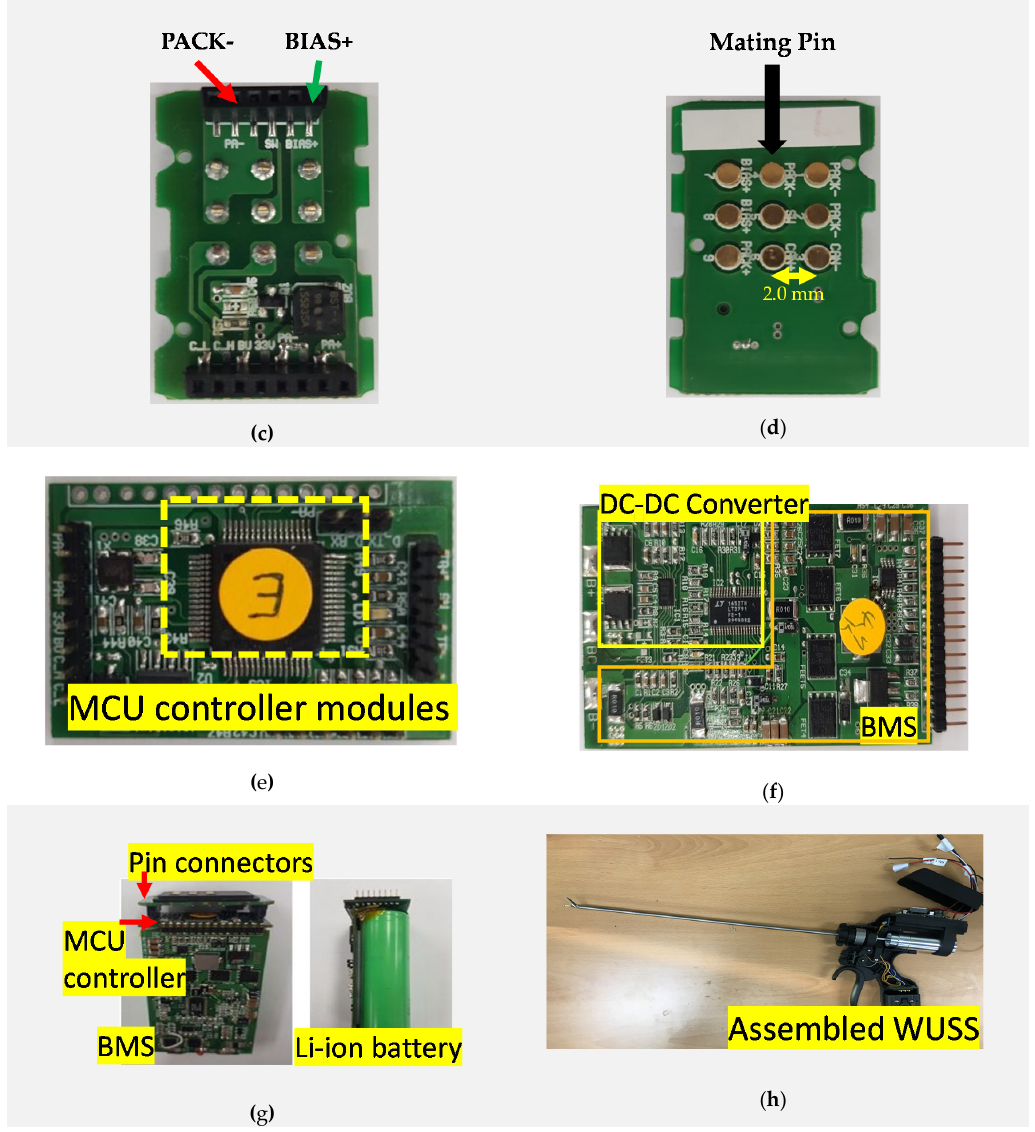
Figure 7. ( a ) Top and ( b ) bottom views of hand instrument pogo pinboards and ( c ) top and ( d ) bottom views of the mating pinboard. ( e ) MCU controller, ( f ) BMS/DC-DC converter boards, ( g ) Li-ion battery with control MCU boards, and ( h ) assembled WUSS.